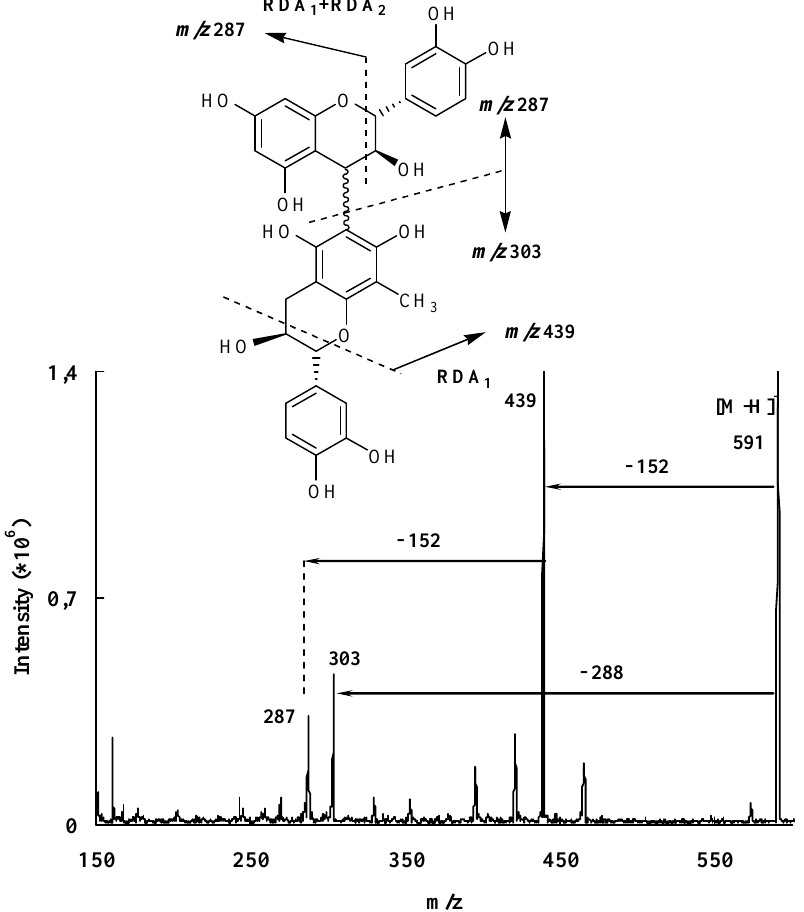
Figure 7. Mass spectrum and main fragmentations observed in compound